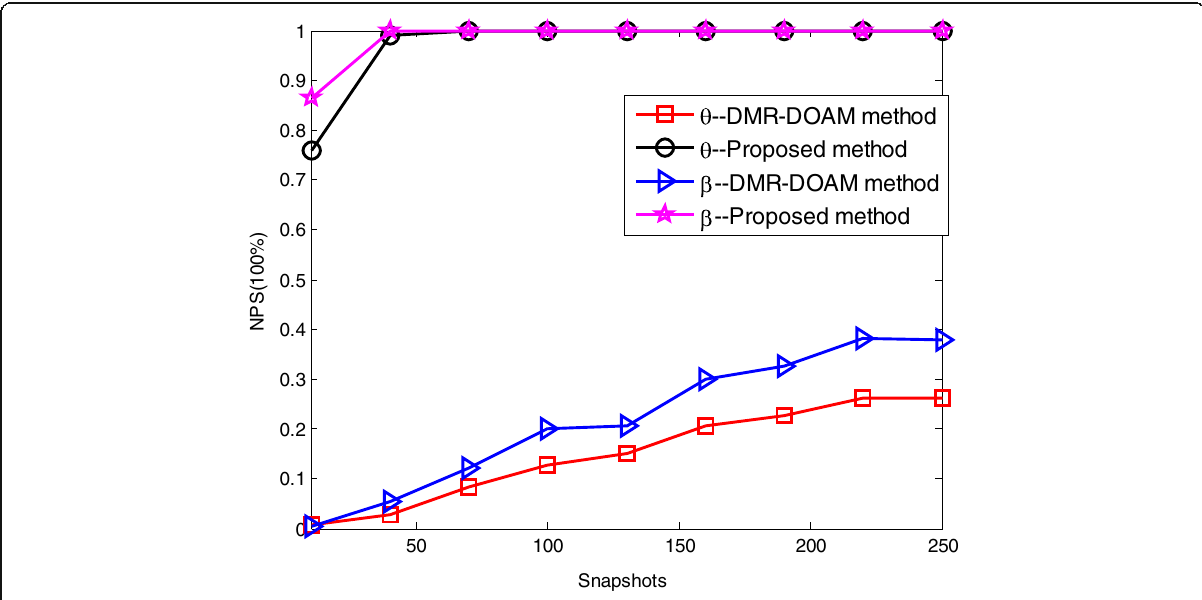
Fig. 5 The NPS of the DOA estimates versus input snapshots